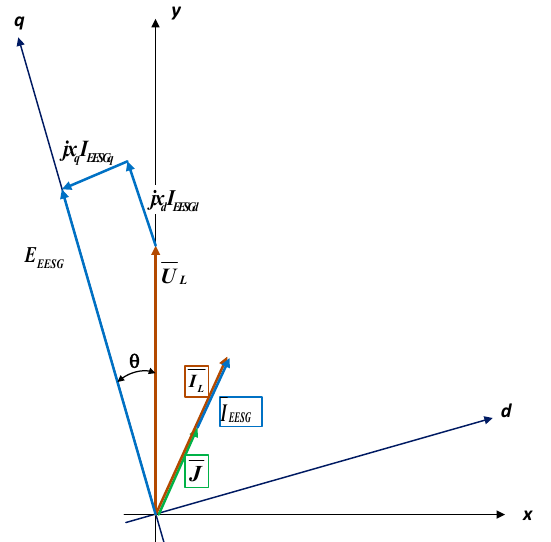
Figure 8. A general vector diagram of the EESG mechatronic system with SGAR + AI.